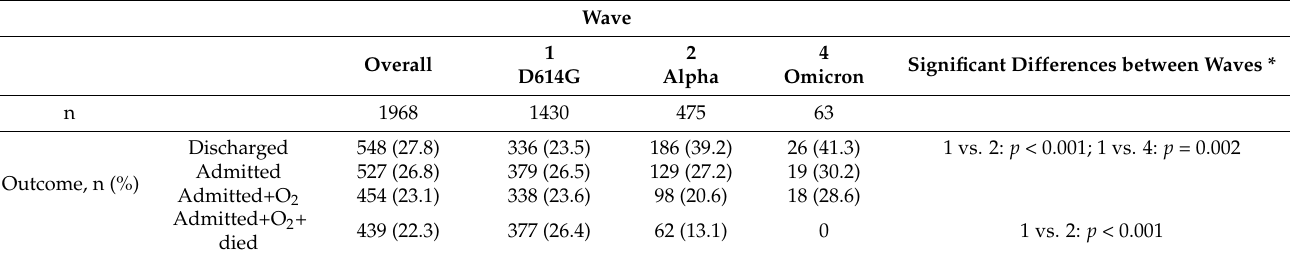
Table 2. Patient outcomes during three SARS-CoV-2 waves. Overall